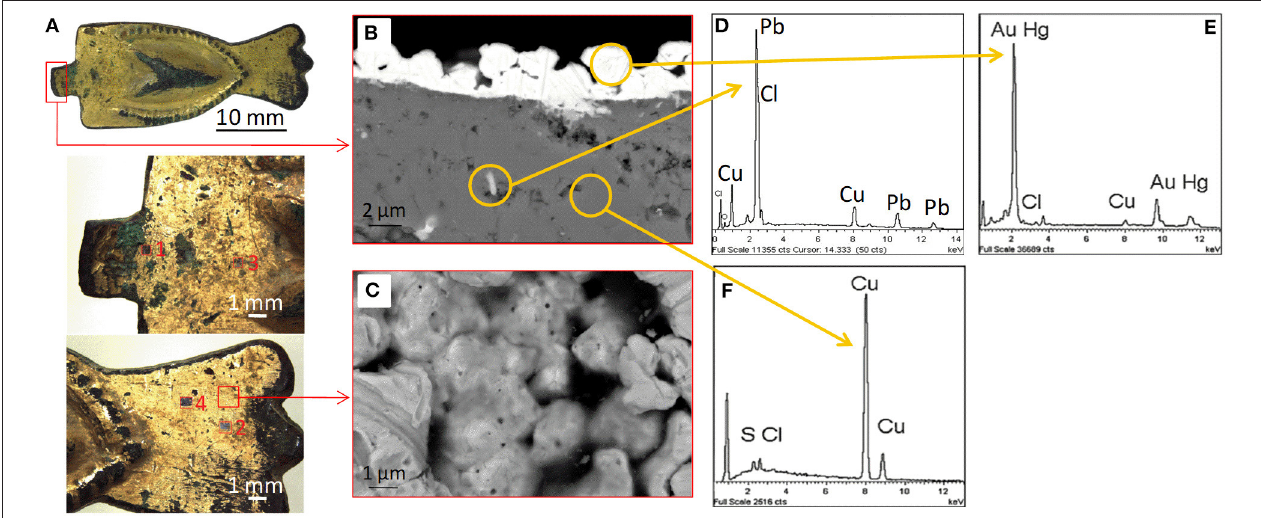
FIGURE 1 | (A) Stereomicroscope image of the buckle with four sampling areas; (B) FE-SEM BSE image of the cross-section of a subsample of the buckle; (C) FE-SEM SE image of the gold grains constituting the gilded layer (top view); (D) EDS analysis on a representative white island in the matrix; (E) EDS analysis on a gold grain; (F) EDS analysis on a corroded